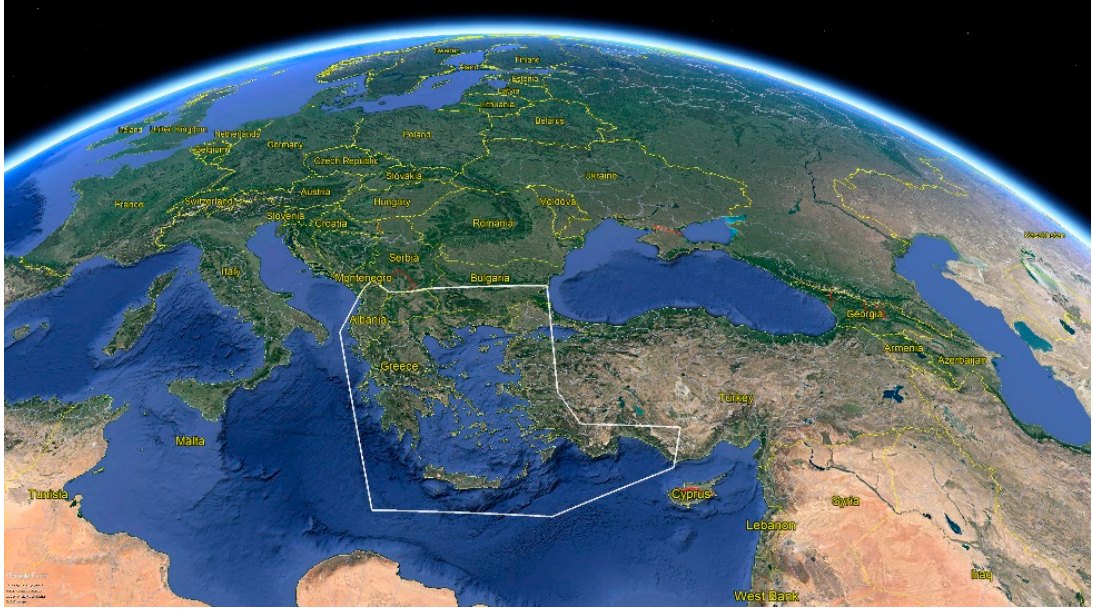
Figure 1. The zone of ethnopharmacological interest in white: Southern Balkans and coastal zone of Asia Minor.